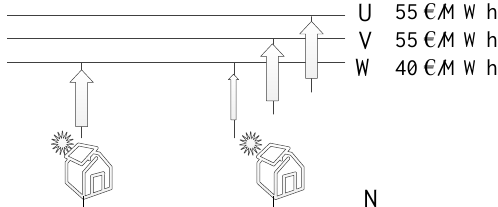
Figure 1. Representation of the arbitrage by a balancing PV inverter. When the price is higher in Phases U and V than in Phase W, more power will be injected into these phases. The width of the arrows represents the amount of active power flowing through the